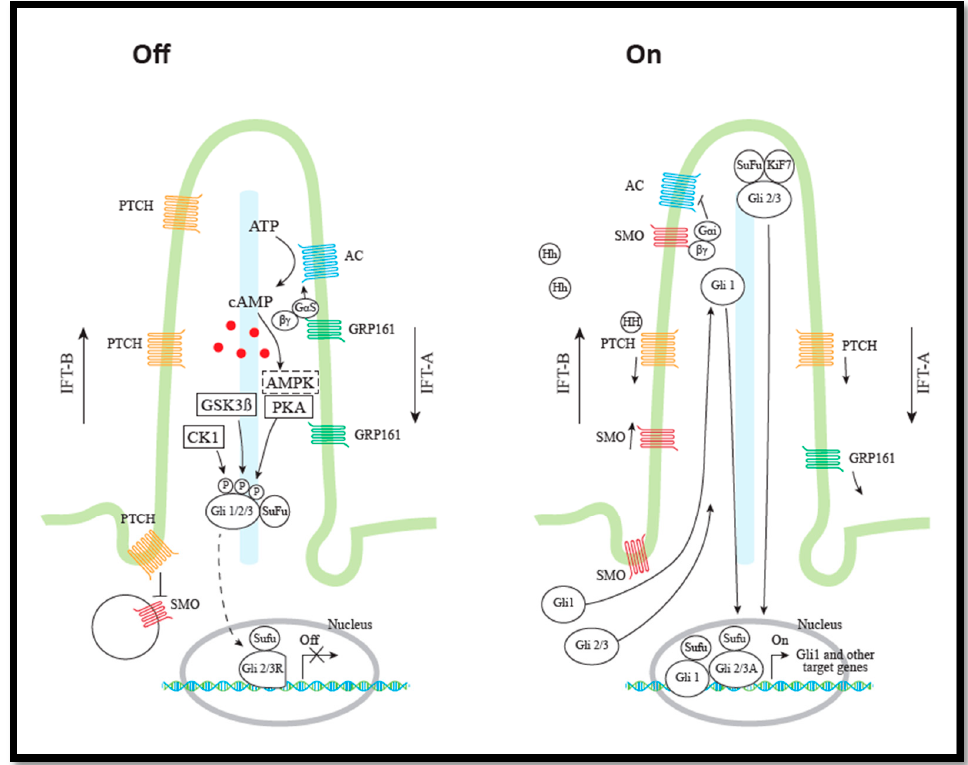
Figure 1. This is a model of Hh signaling in the primary cilium. To the left, Hh in the Off state. To the right, Hh in the On state. In the Off state, GRP161 and PTCH1 are in the primary cilia. GRP161 inhibits Hh signaling by activation of PKA, leading to phosphorylation of GLI. GLI2/3 are subsequently phosphorylated by CK1 and GSK3B and either proteolytically degraded to GLI2/3Rep or completely degraded. AMPK can also perform the priming phosphorylation of GLI. SUFU inhibits GLI. In the On state, Hh activation leads to removal of PTCH from the cilium, and entrance of SMO. The presence of active SMO in the cilium permits the export of GRP161. SMO prevents GLI degradation by downregulation of PKA. The full-length GLI1/2/3FL are accumulated and translocated to the nucleus in the active GLI1/2/3A form, leading to transcription of the Hh target genes (e.g., GLI1, PTCH1, AKT, NKX2.2 ) The IFT-B complex is involved in anterograde transport and the IFT-A in retrograde transport. See text for further details.